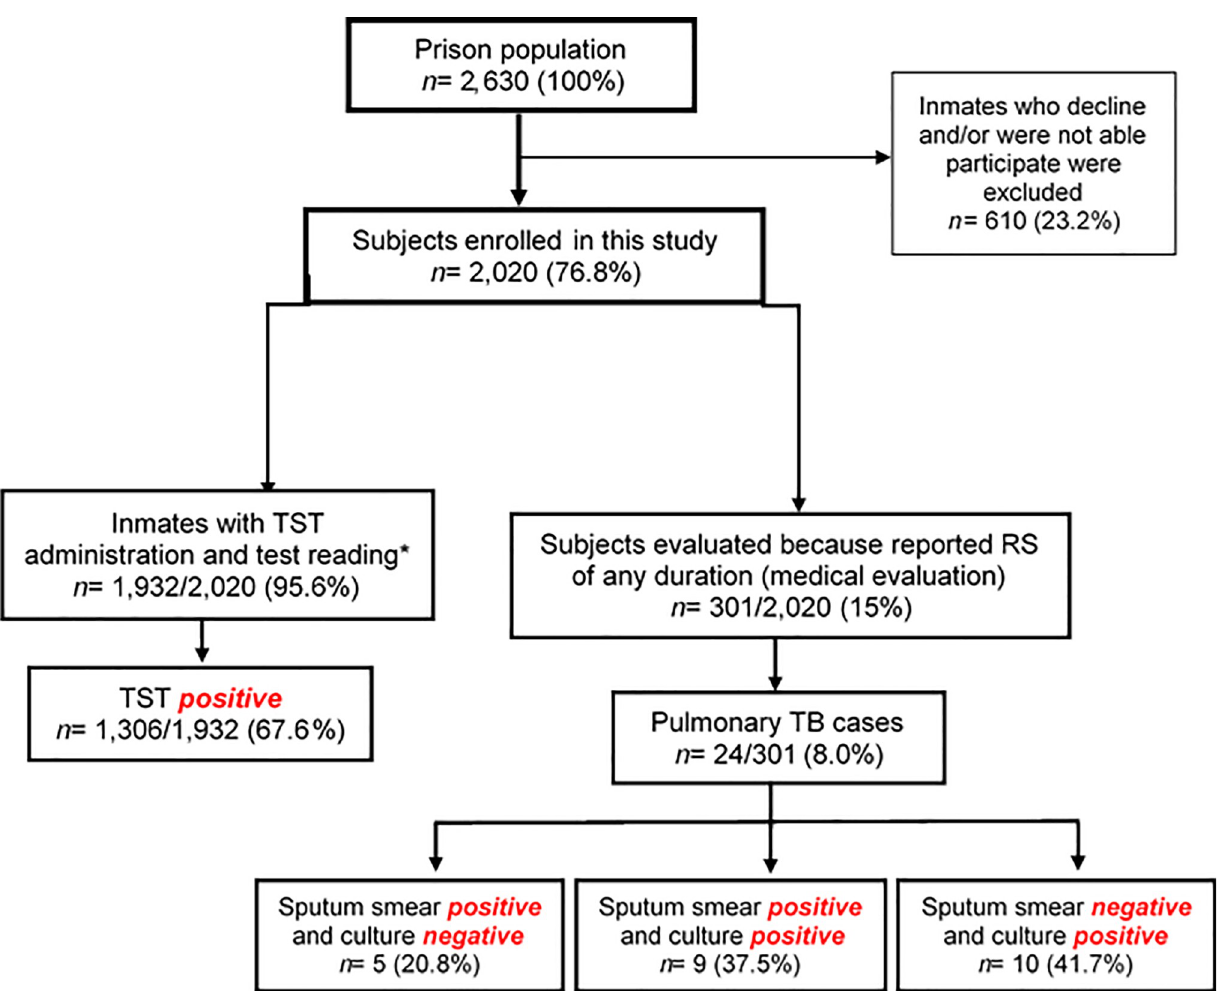
Fig 1. Flowchart of inmates included in the study. � Refusal to participate, reading could not be performed and/or some inmates were involved in prison routine activities or outside permission.